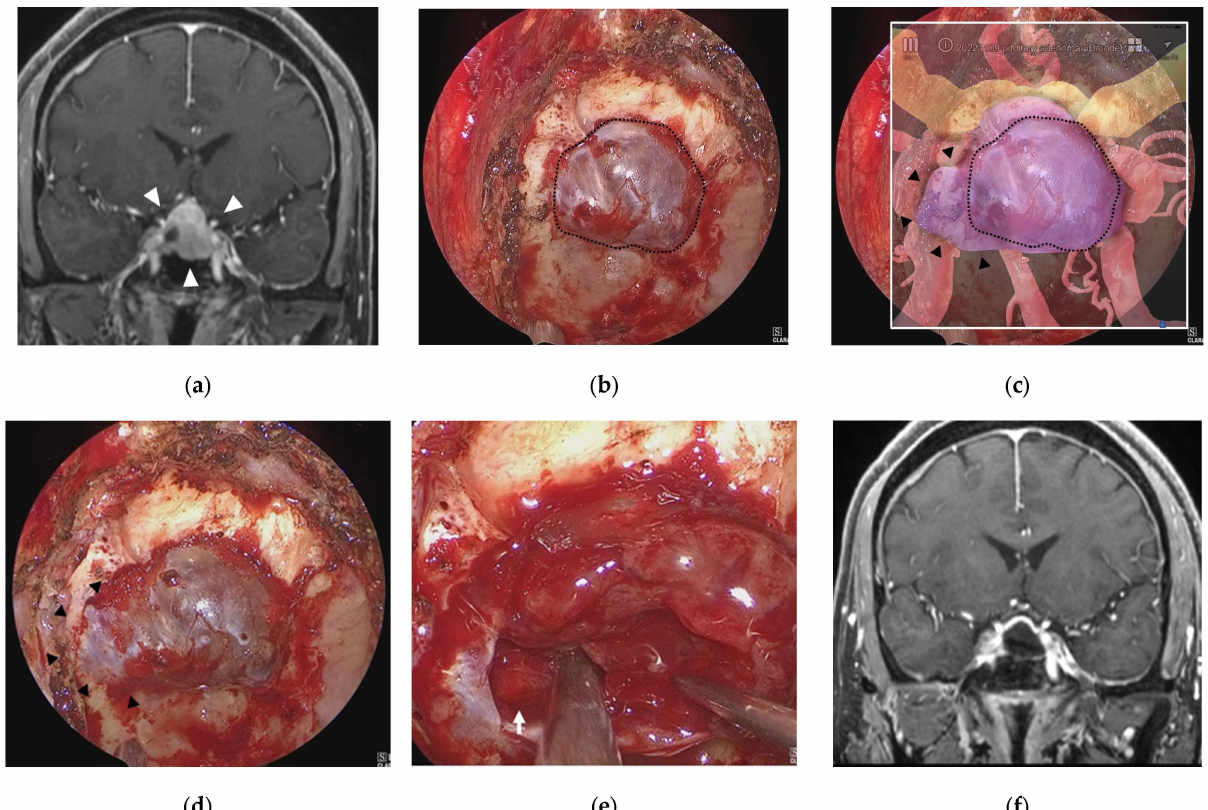
Figure 4. Illustrative case 1. ( a ) Coronal section of preoperative gadolinium enhanced T1 weighted image shows a sellar tumor with suprasellar extension (white arrowheads). ( b ) Endo- scopic view of the sphenoid sinus after removal of bone around the sella turcica (dotted